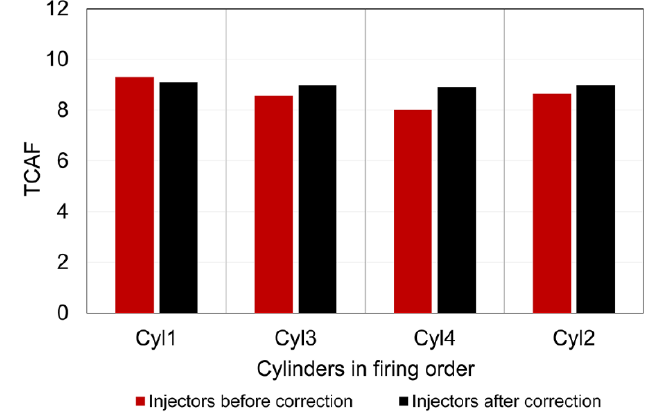
Figure 21. Results of the injection correction on the old set of injectors in terms of TCAF. Engine operating condition: 1500 rpm at full load.